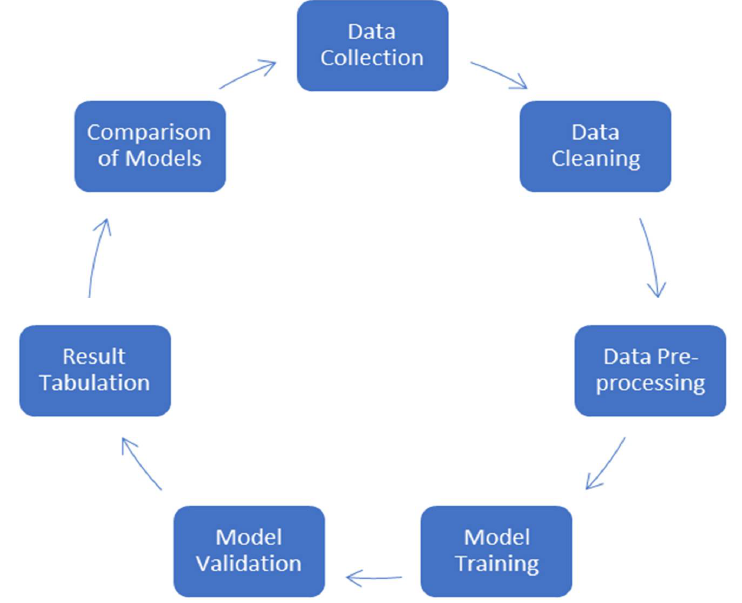
Figure 1. Solution Architecture of the ensemble Machine Learning algorithms.